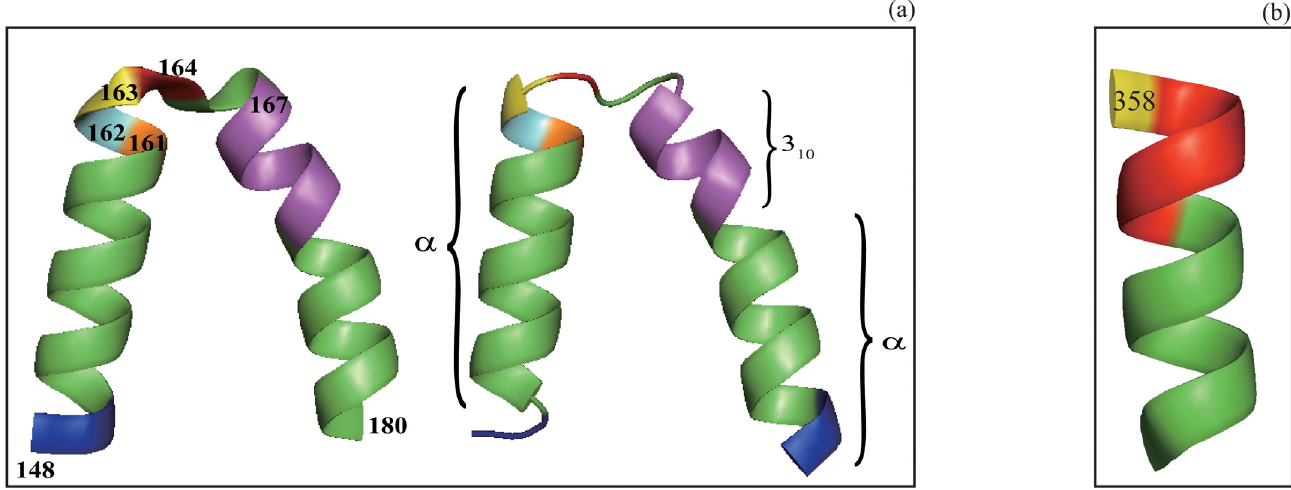
Fig 4. The illustration of the differences in assignment by our algorithm and DSSP . In (a) a segment (residues 148 – 180) in a protein (pdbid 1DI1) assigned as a single α -helix by DSSP is shown in the left with residue 163 colored in yellow. Our algorithm divides the same segment into three different helices (the right figure): α -helix – 3 10 – helix – α -helix. The first helix assigned by our algorithm starts with residue 150 since both residues 148 and 149 have h i > h T and stops at residue 163 (colored in yellow) since its h i > h T and no merge is triggered because that a i = 85.12° > a max = 40.0° for the three residues 164 (colored in red), 165 and 166. The residues 164 – 166 all have h i > h T , so the next helix starts with residue 167. In contrast to DSSP our algorithm assigns the segment of residues 167 – 171 as a